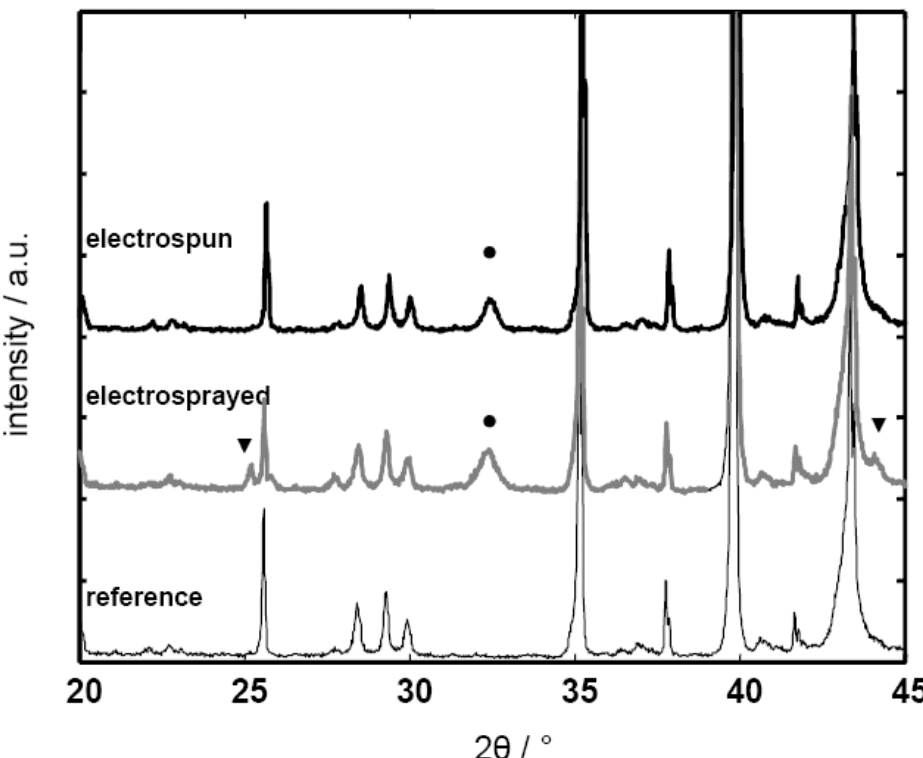
Figure 5. XRD data of a SrTi Fe O electrospun film (top) and a SrTi 0.8 0.2 3- d electrosprayed film (middle); the complex XRD spectrum of the bare transducer (alumina substrate/ SrAl O underlayer /platinum electrodes) has been added as a reference 2 4 (bottom). The peaks attributed to the cubic perovskite phase are denoted with ● , the strontium carbonate phase peaks are marked with ▼